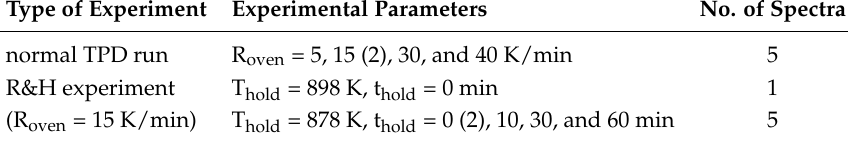
Table 2. Independent experiments used for the fit of the binding energy distribution. The table lists the type of experiment and the different experimental parameters that were used. Some data sets were measured twice (indicated by (2) behind the parmeter value). In that case both data sets were used for the fit.